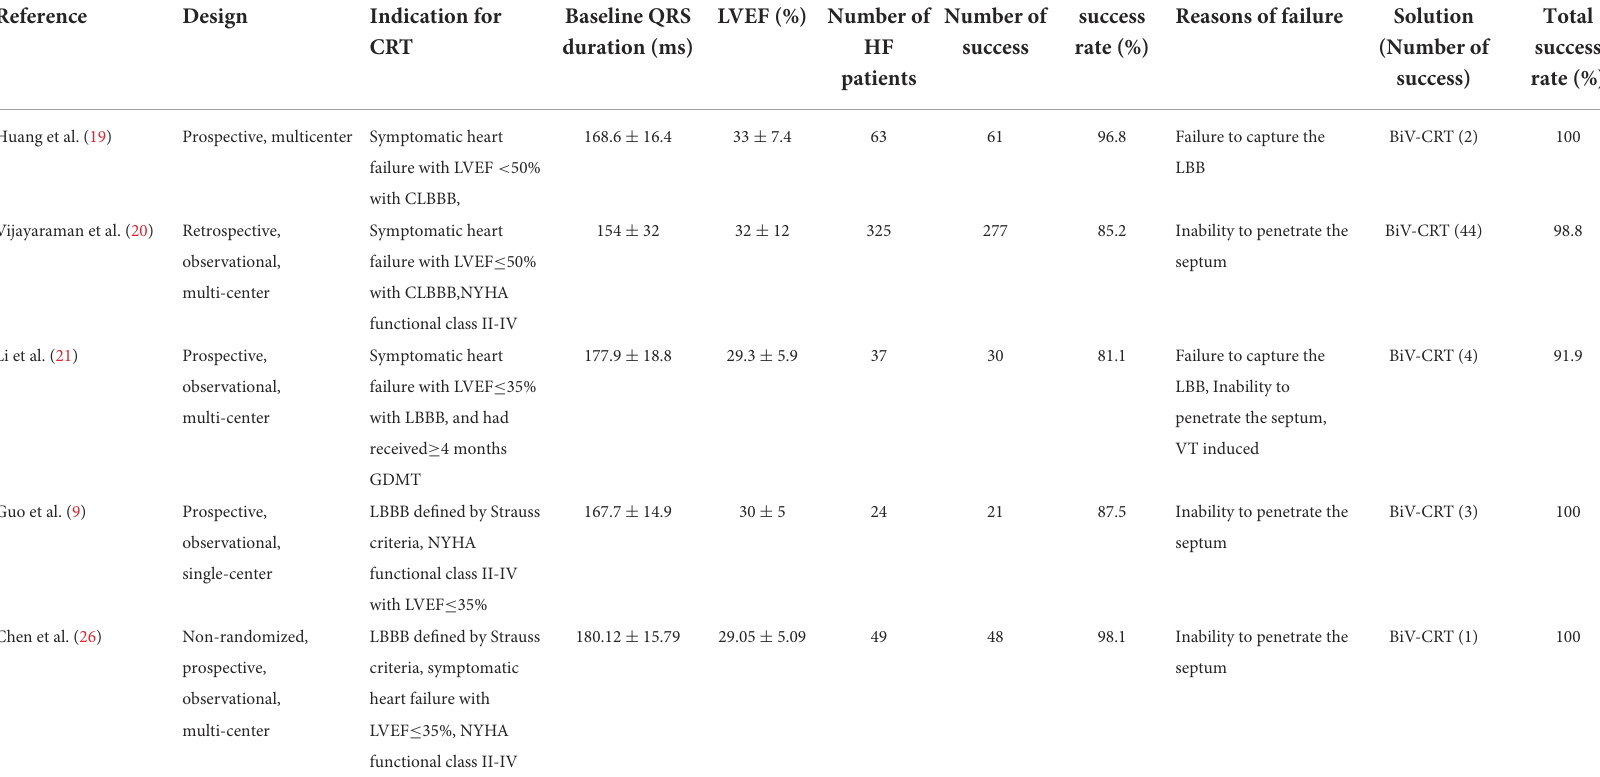
TABLE 1 Characteristics of studies included in the